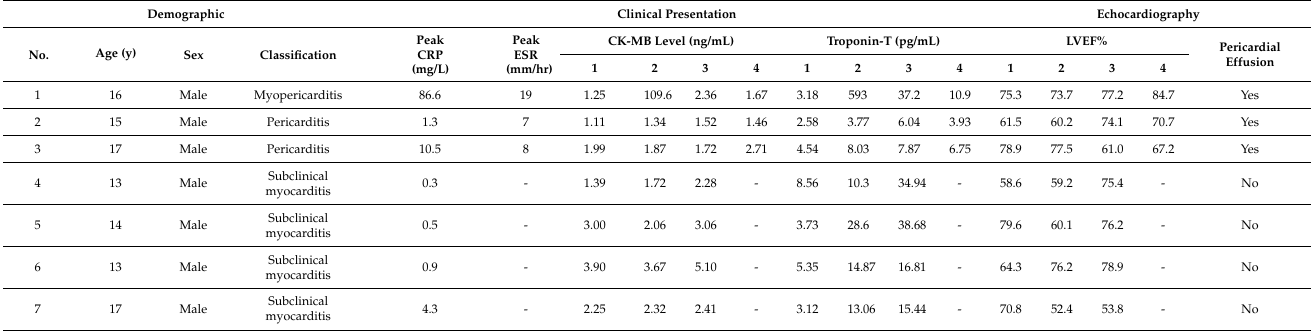
Table 3. Characteristic of patients with elevated biomarker levels or positive lab assessments.